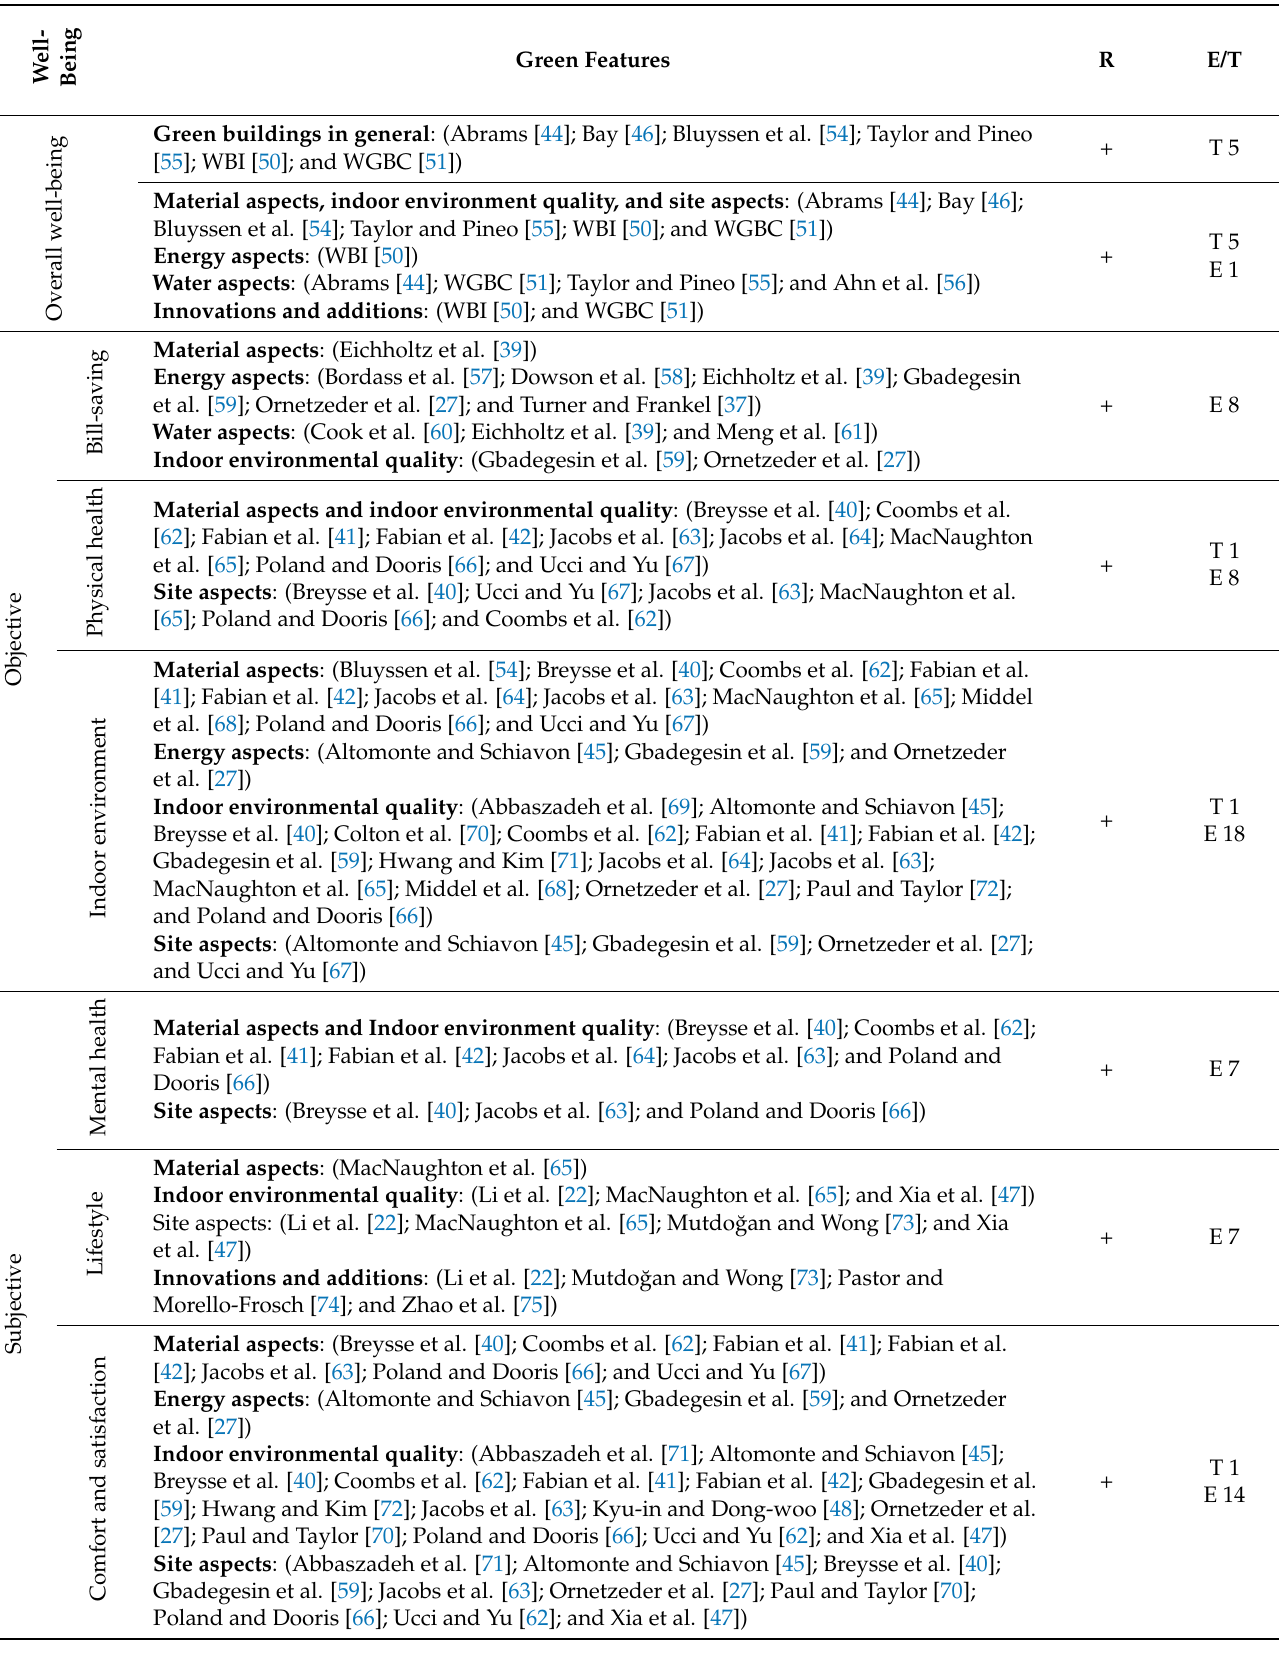
Table 1. Different green building aspects matched with the dimensions of occupant well-being (“+” denotes a positive relationship, T that the study is theoretical, and E